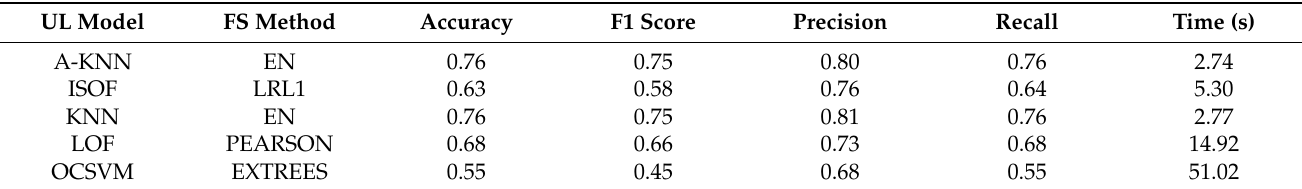
Table 12. Individual unsupervised learning model best performance